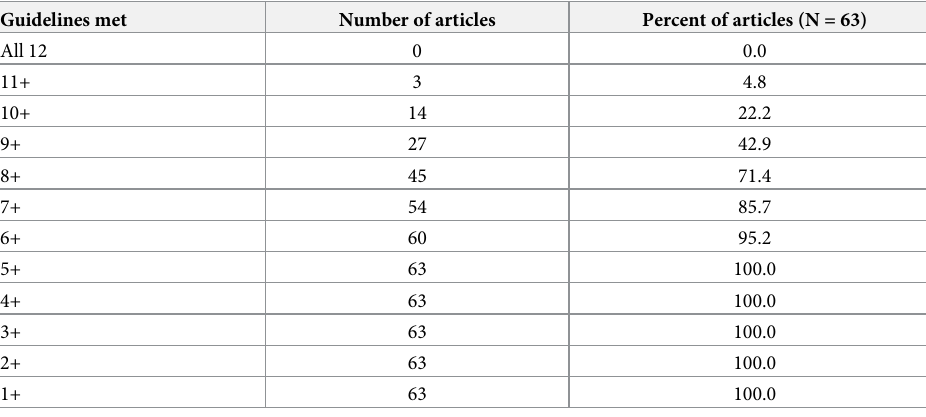
Table 3. Cumulative proportion of articles meeting each